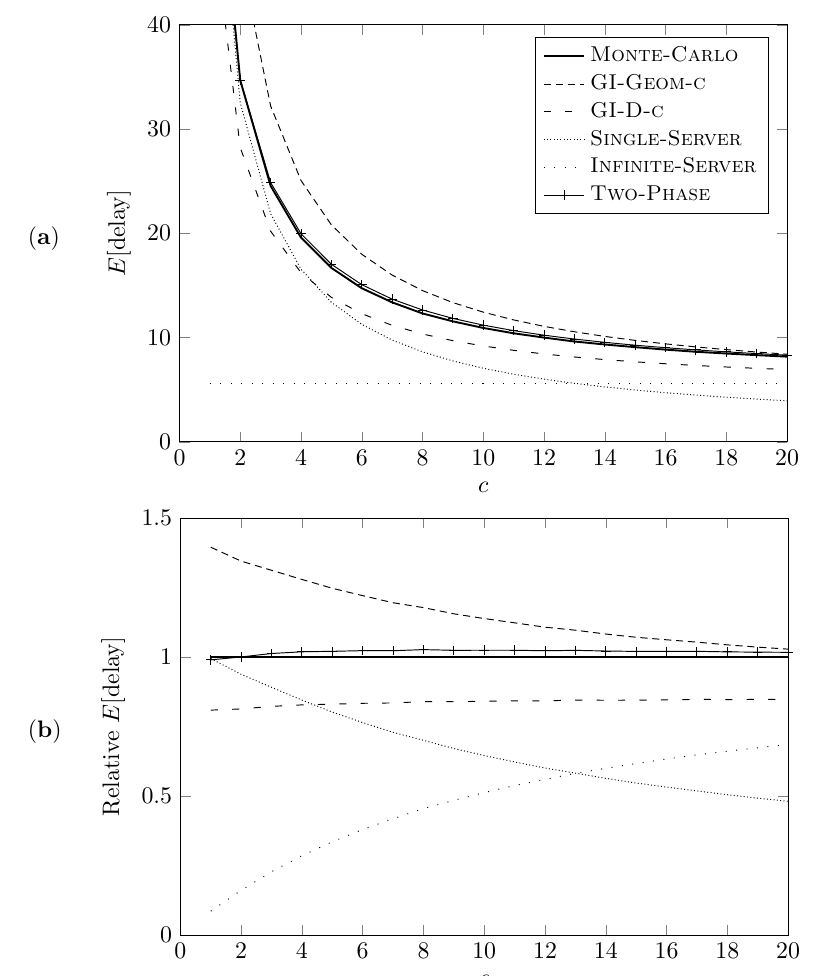
Figure 2. Mean customer delay versus the number of servers c for a system with Poisson arrivals, shifted negative-binomial service demands with 5 phases and mean τ = 50, and negative-binomial service capacities with 5 phases and mean µ = 10, with variable mean arrival rate λ such that the load ρ = 0.95, as estimated by various approximations: ( a ) in absolute value; and ( b ) relative to the M ONTE -C ARLO